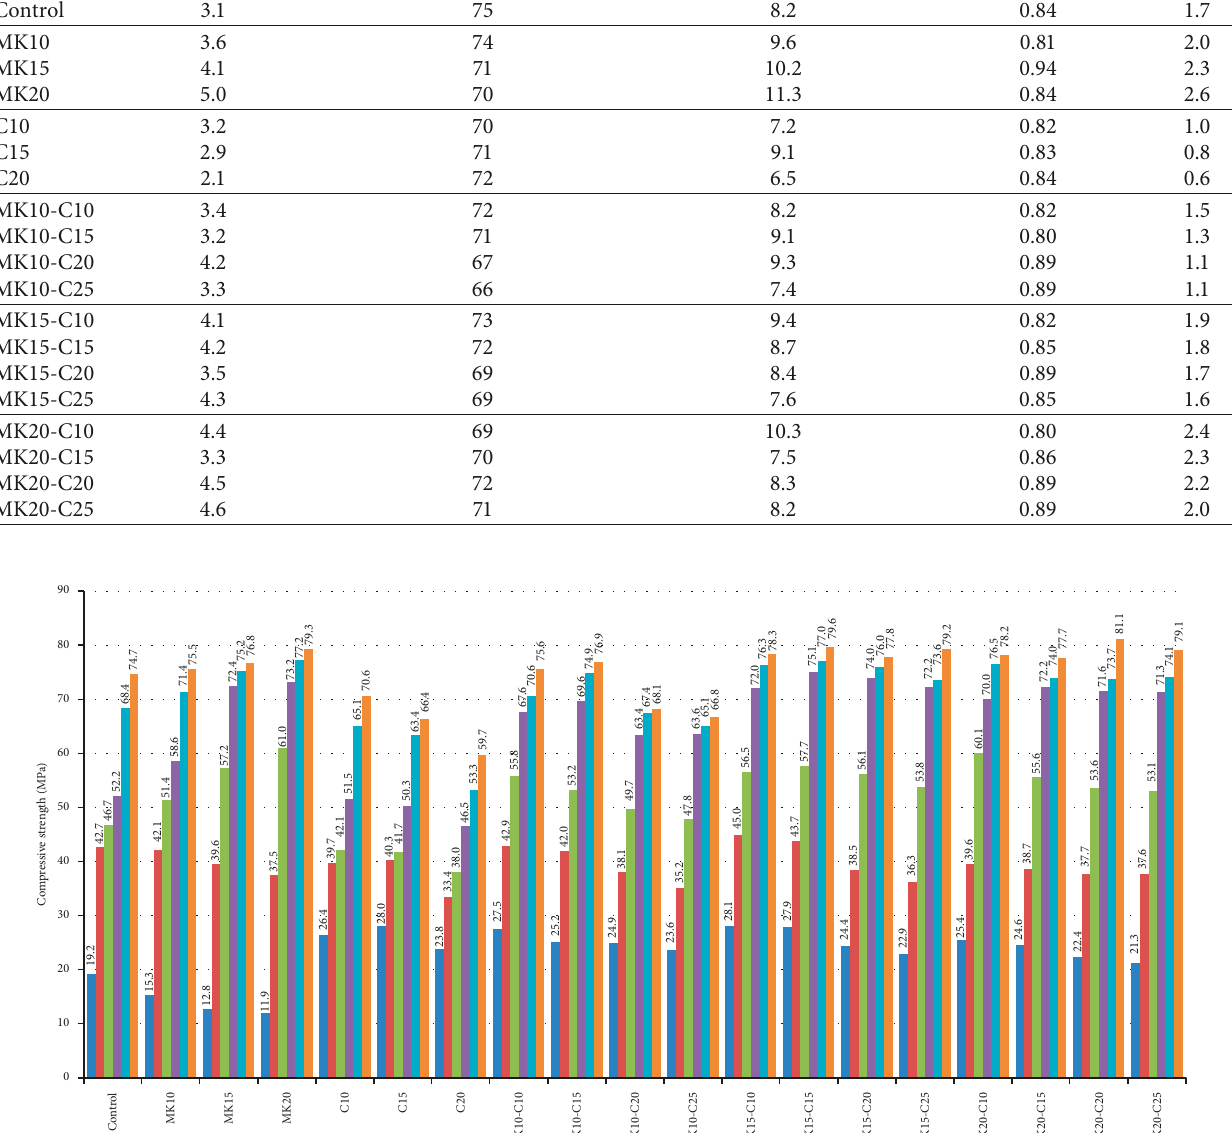
Table 6: Fresh concrete workability and consistency testing for SCC. Mix